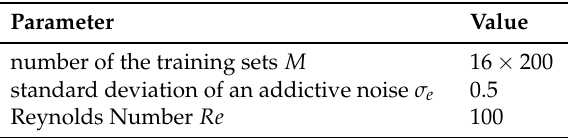
Table 3. Parameters for training data.